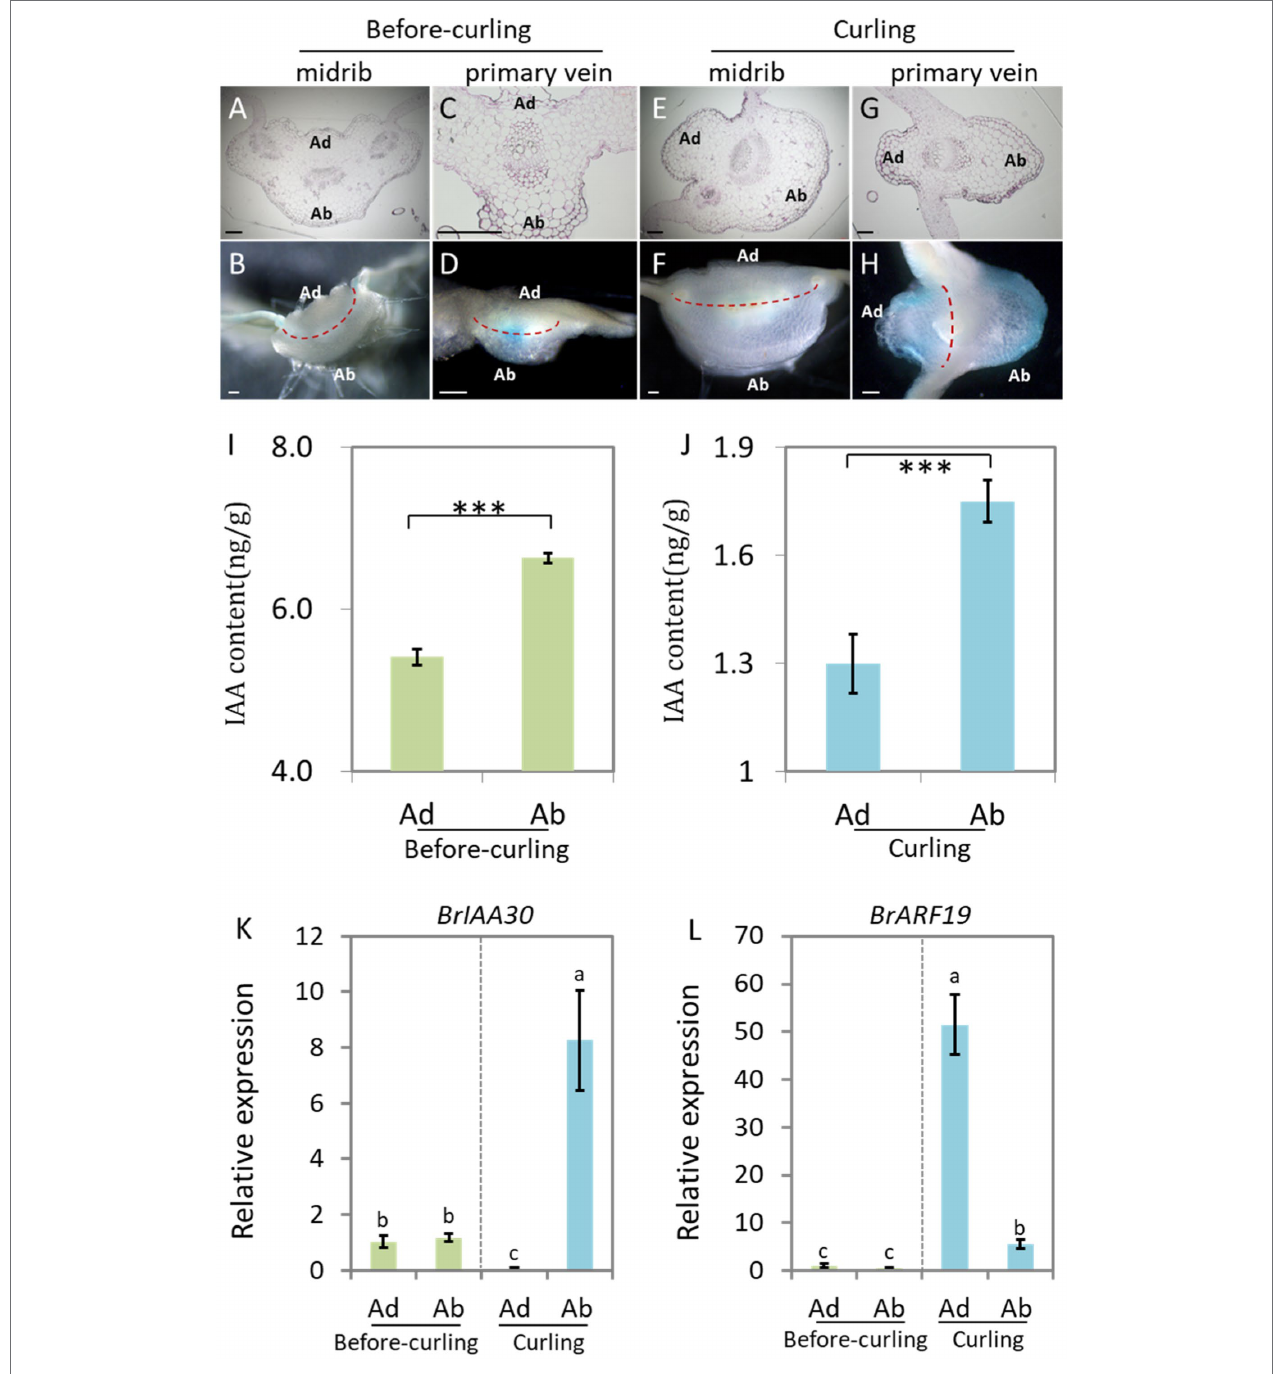
FIGURE 3 | Auxin shows abaxial/adaxial distribution in the leaf veins. Transverse sections of GUS stained leaf veins in before-curling plants from Figure 1B (A–D) and curling plants from Figure 1H (E – H) . (A,B,E , F) Midribs; (C , D , G , H) primary veins. (A , C , E , G) Ultrathin sections; (B , D , F , H) free-hand sections. (I,J) Measurement of endogenous IAA in midribs of the before-curling and curling leaf veins of which developmental stages were displayed in Figures 1B,H . (K,L) Expressions of BrIAA30 and BrARF19 in midribs of before-curling and curling plants, respectively. Error bars represent the standard errors derived from three replicates. Asterisks indicate significant differences using Student’s t -test *** p < 0.01. Different lower case letters represent highly significant differences by Student’ s t -test, p ≤ 0.01. The materials (I–L) used for analysis were taken from the leaf parts shown in Supplementary Figures S3E,F . Scale bars: 200 μ m. Ad/Ab,